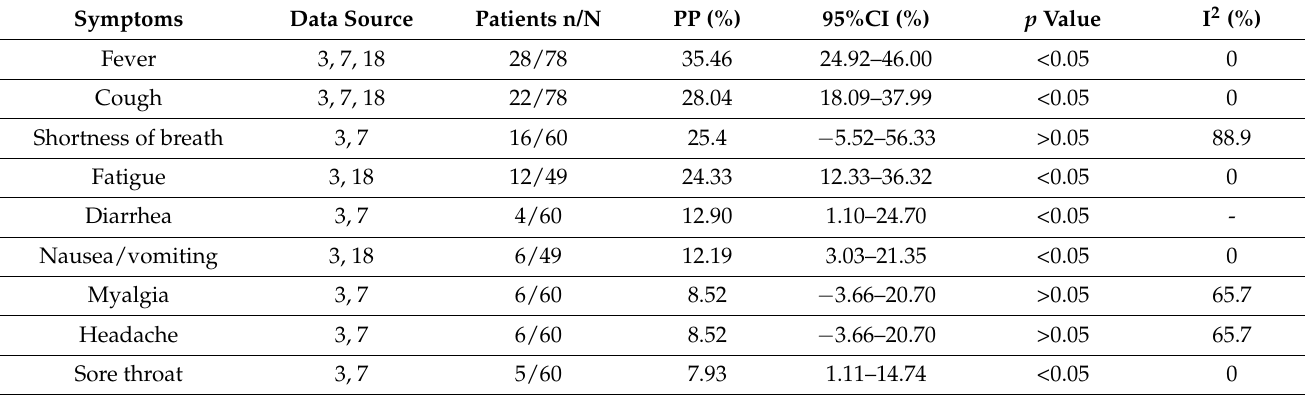
Table 2. Pooled prevalence (PP) of symptoms of symptomatic SARS-CoV-2 reinfection.